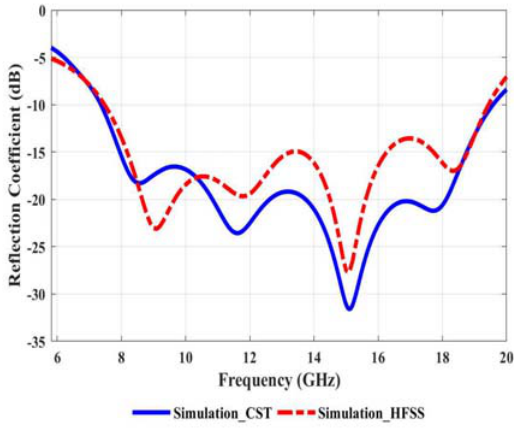
Fig. 4. Simulated reflection coefficient of the proposed